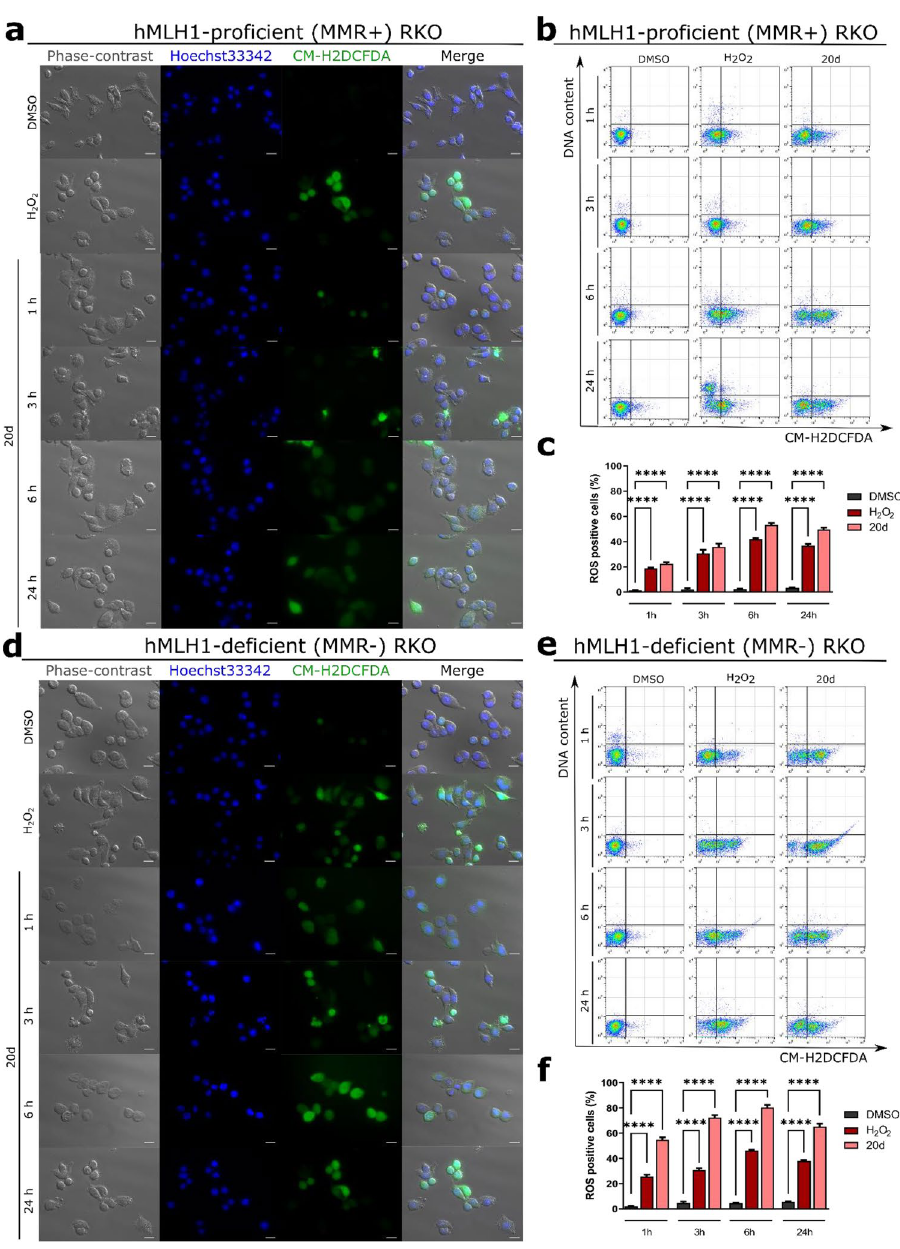
Figure 7. Effect of 20d treatment on ROS induction in hMLH1-proficient and hMLH1-deficient RKO cells after 1, 3, 6, and 24 h of exposure. ( a , d ) Representative microscopic images of H2DCFDA-stained cells. Scale bar = 50 µm. ( b , e ) Representative dot plots of H2DCFDA-stained RKO cells. DMSO and H 2 O 2 were used as reference compounds. ( c , f ) Quantification of dot plots is depicted as mean ± SEM of data obtained from three independent